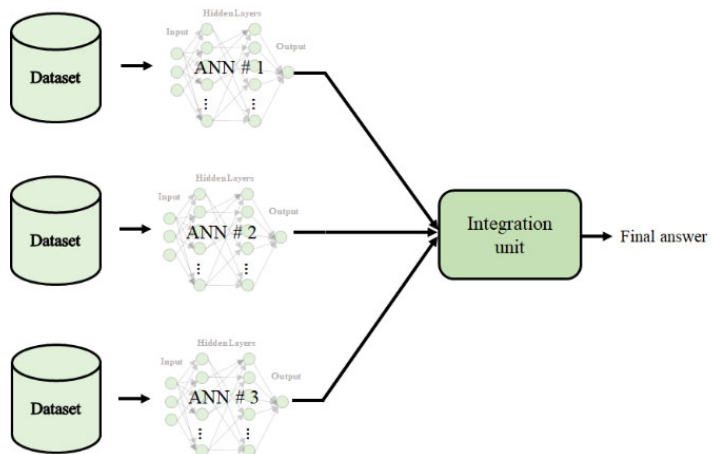
Figure 2. Ensemble neural network.